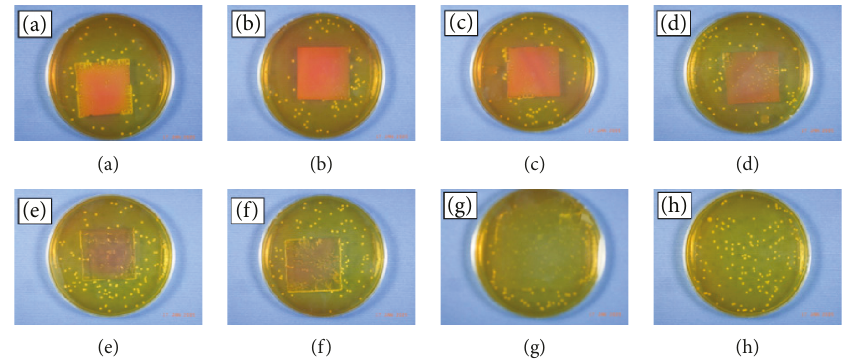
Figure 2: E ff ect of the DDA of chitosan on the growth inhibition of S. aureus . Higher DDA was more e ff ective on inhibiting the growth of S. aureus : (a) DD 92.2%; (b) DD 90.1%; (c) DD 88.0%; (d) DD 83.9%; (e) DD 79.7%; (f) DD 75.5%; (g) PVC; (h) control (adapted from